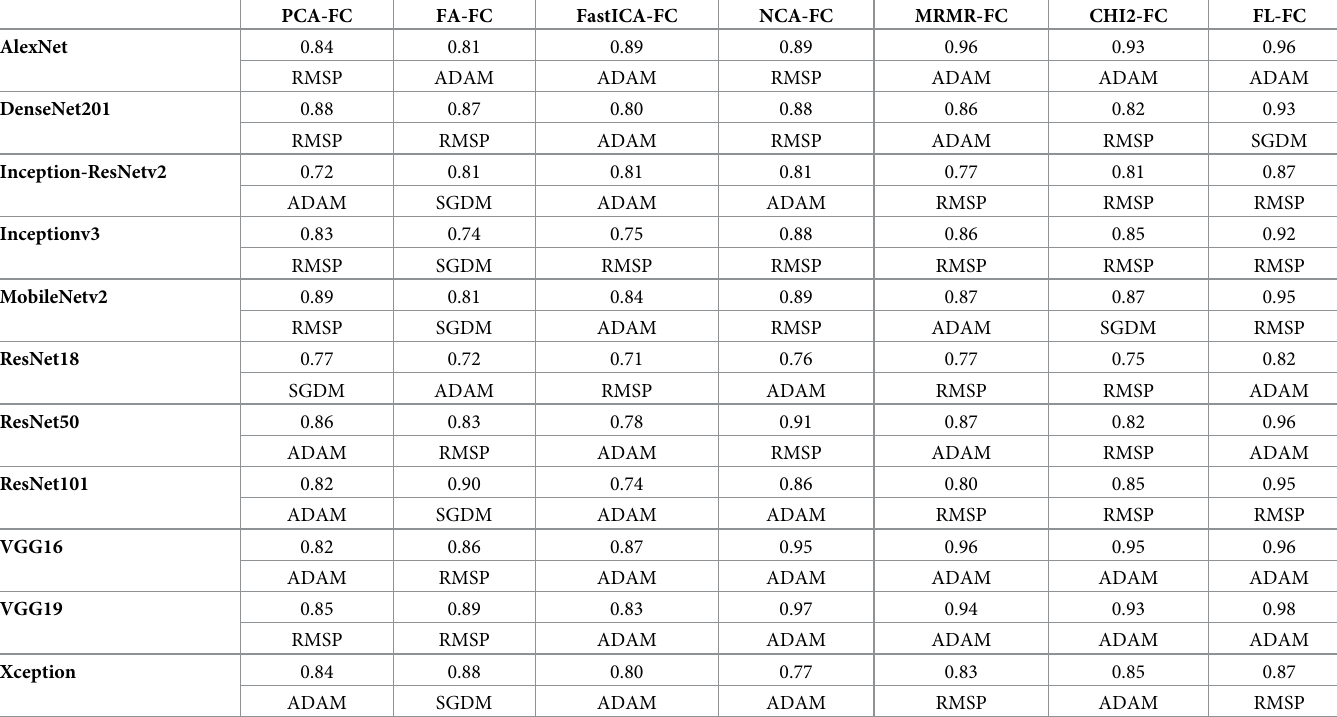
Table 12. The best FC learning optimizer for each combination method and its average classification performance (using Precision metric). PCA-FC FA-FC